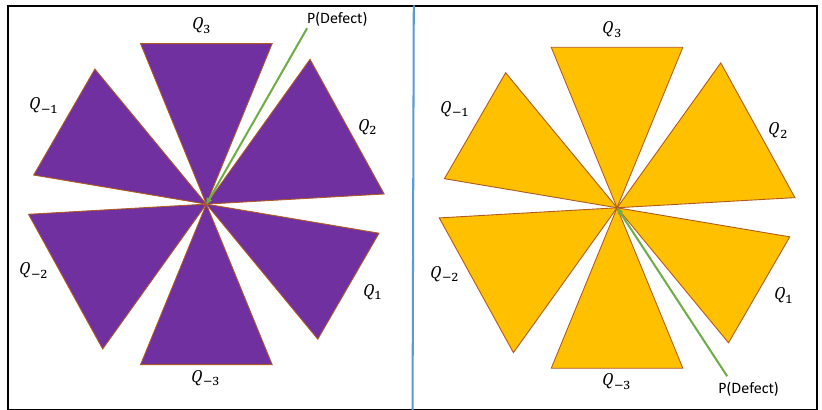
Figure 5 . Braneworld consists of d -dimensional anti de-Sitter and de-Sitter spacetimes. AdS spacetimes are embedded in the bulk (2.3) where as de-Sitter spacetimes are embedded in the bulk spacetime with metric (3.7). We have used n